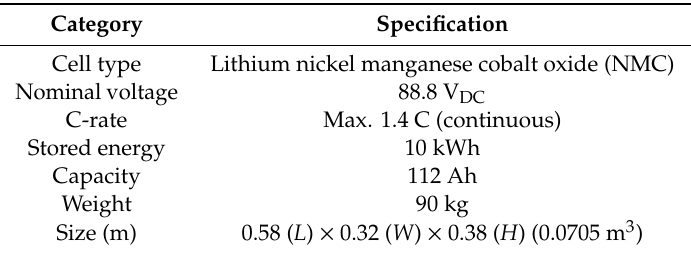
Table 5. Specifications of the selected LIB module